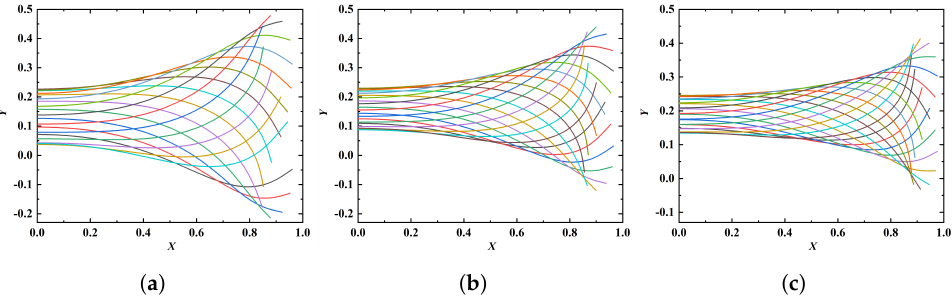
Figure 7. U c and COT as a function of k . The absolute value of U c is plotted here since the propulsor is swimming in the negative x -direction.